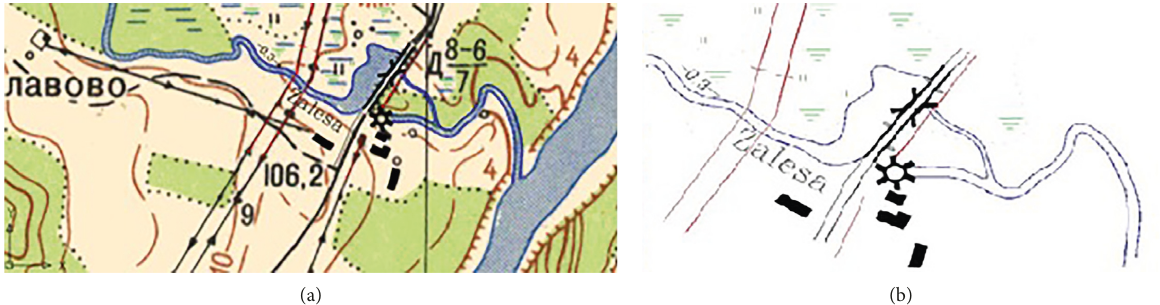
Figure 7: Digitized section of River ˇZalesa is represented in the topographic map of 1972 (source: http://www.geoportal.lt and authors’ digitalization).